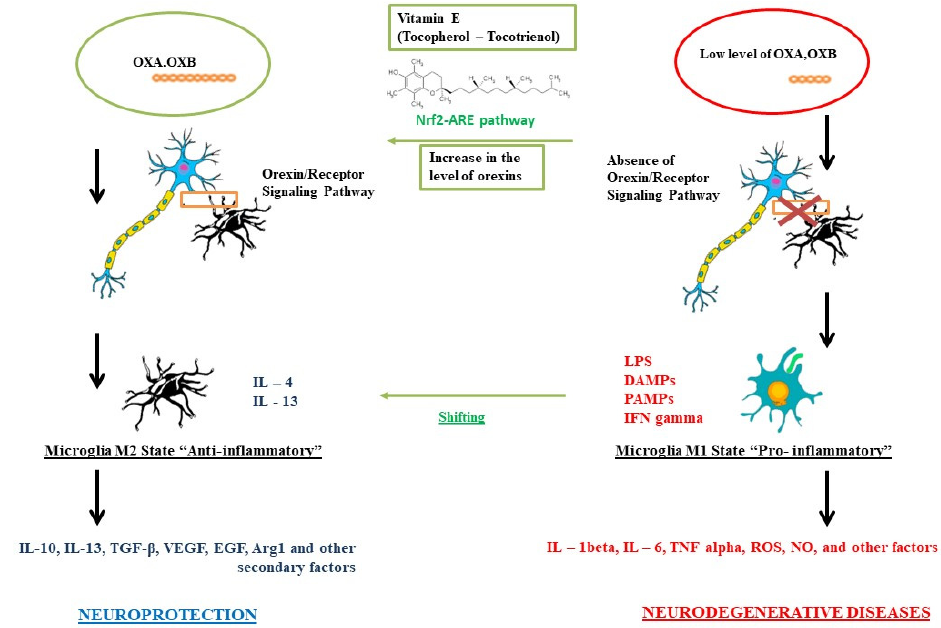
Figure 1. Role of vitamin E on the orexinergic system for neuroprotection.